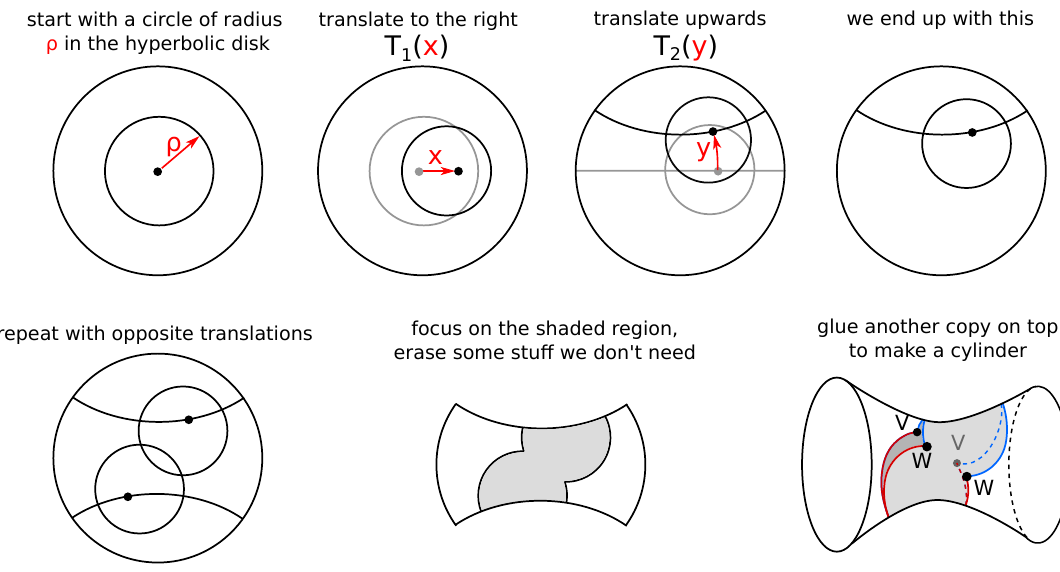
Figure 16 . (Adapted from [27] with permission). This gives the cut-and-paste construction of the wormhole [27] that contributes to the Renyi-2 entropy. In Stanford’s context, the wormhole arises from inserting 2 pairs of operators; in our context, these operators are boundary condition changing operators that arise from turning on a marginal source. At large Lorentzian times, we end up with essentially the same wormhole. If we already know the 2-operator disk solution, a “shortcut” procedure is to start with the solution on the bottom left, with some auxiliary inverse temperature β aux . When we “erase some stuff we don’t need,” we are left with a boundary of length β aux − β E . After gluing to a second copy, we get the constraint β = β aux − β E